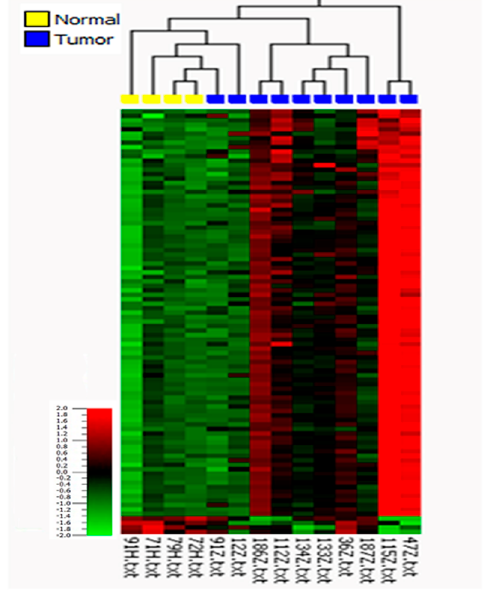
Figure 3. Heat map after unsupervised hierarchical clustering of differentially expressed miRNAs in usual (HPV-negative) tumors versus related normal tissue samples ( p ≤ 0.05; q ≤ 0.23; fold change ≥ 2).